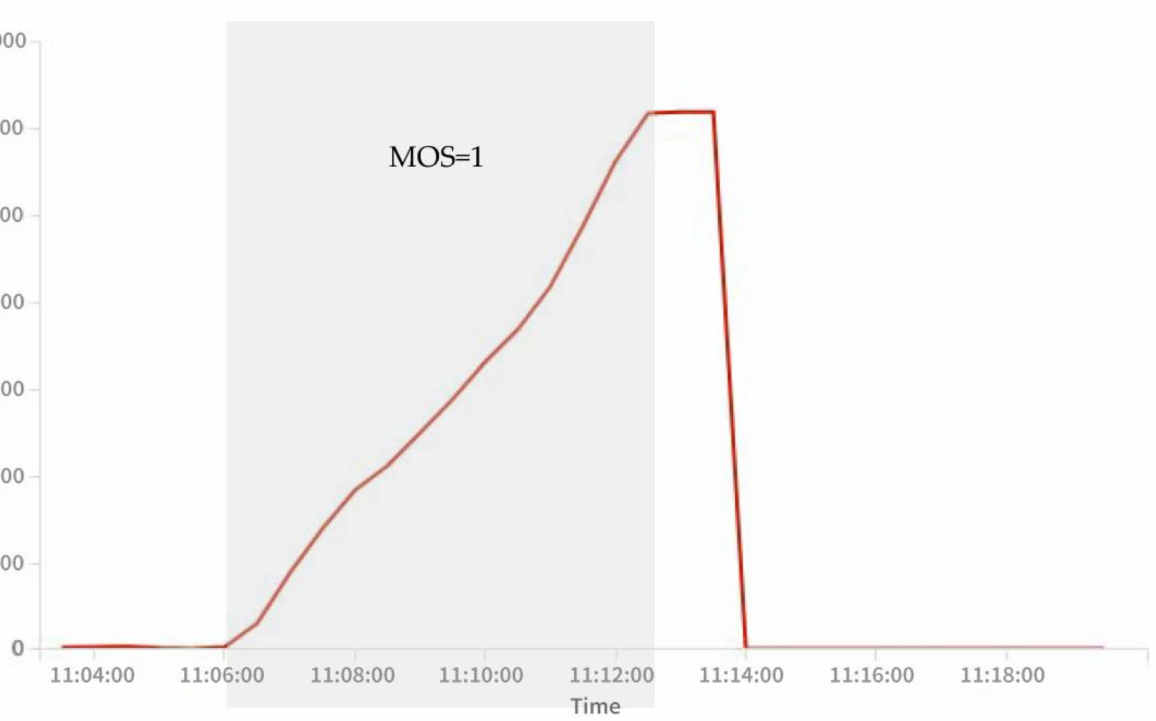
Figure 6. Number of retransmitted packets to a